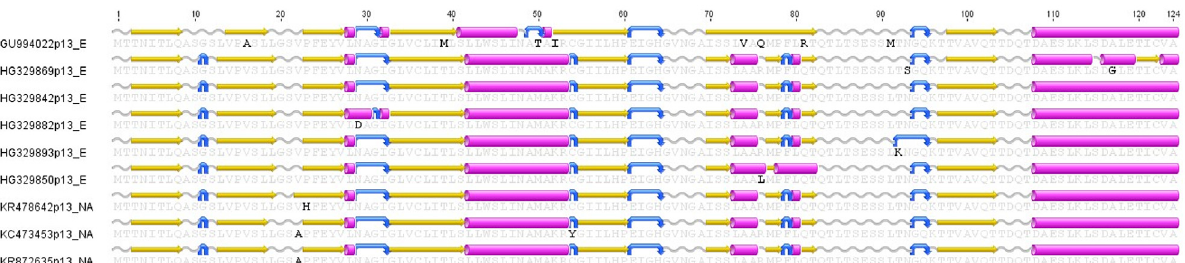
Fig 4. Amino acid alignment of open reading frame consensus sequences encoding the Piscine reovirus p13 protein. Secondary structure and transmembrane domains were predicted using EMBOSS 6.6.7 (Geneious software v6.1). Predicted secondary structure of alpha helix, beta strand, coil and turn are presented in purple cylinders, yellow arrows, grey sinusoids and blue curved arrow. Detailed information of individual sequences are presented in S2 Table.